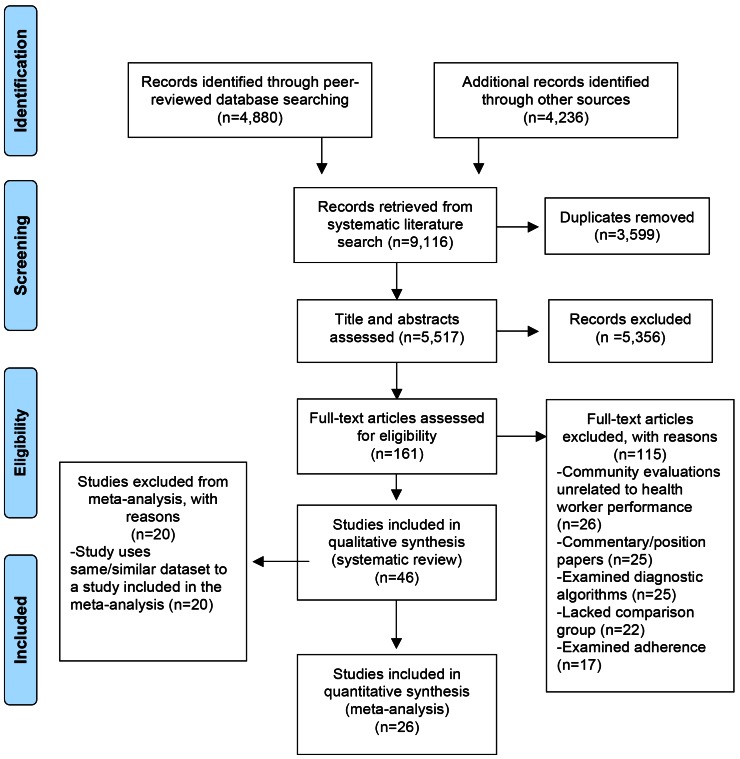
PRISMA flowchart.